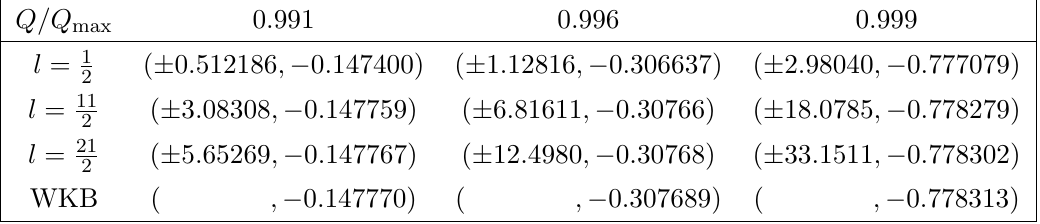
Table 4 . The low-lying QNMs !